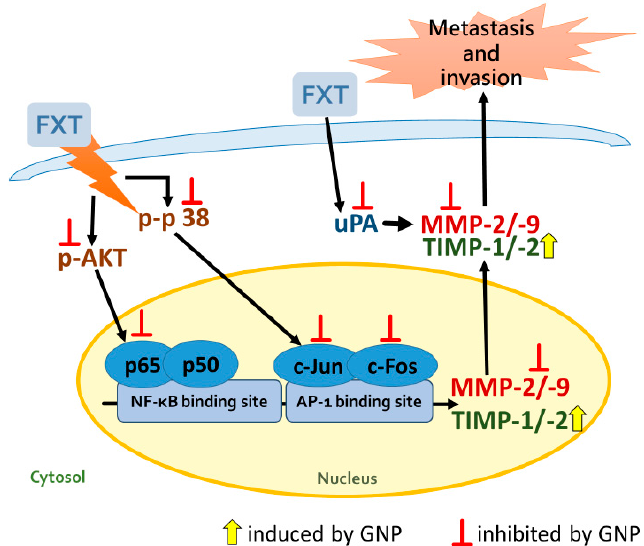
Figure 8. Proposed signal transduction pathways of GNP to inhibit the FXT-induced cell metastasis and invasion of HepG2 cells.